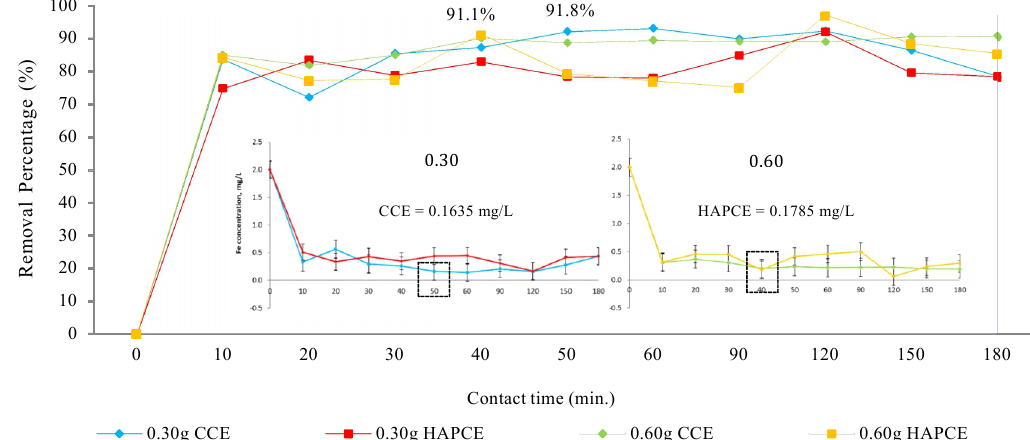
Fig. 3: Iron (II) percentage removal for optimized dosage and contact time with final concentration of aqueous solution